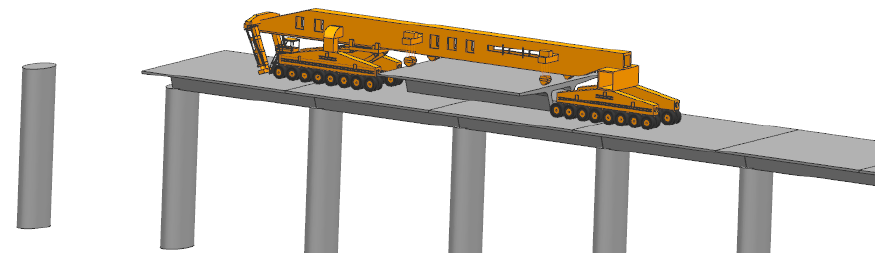
Figure 19. Construction site of mobile bridge erecting machine.